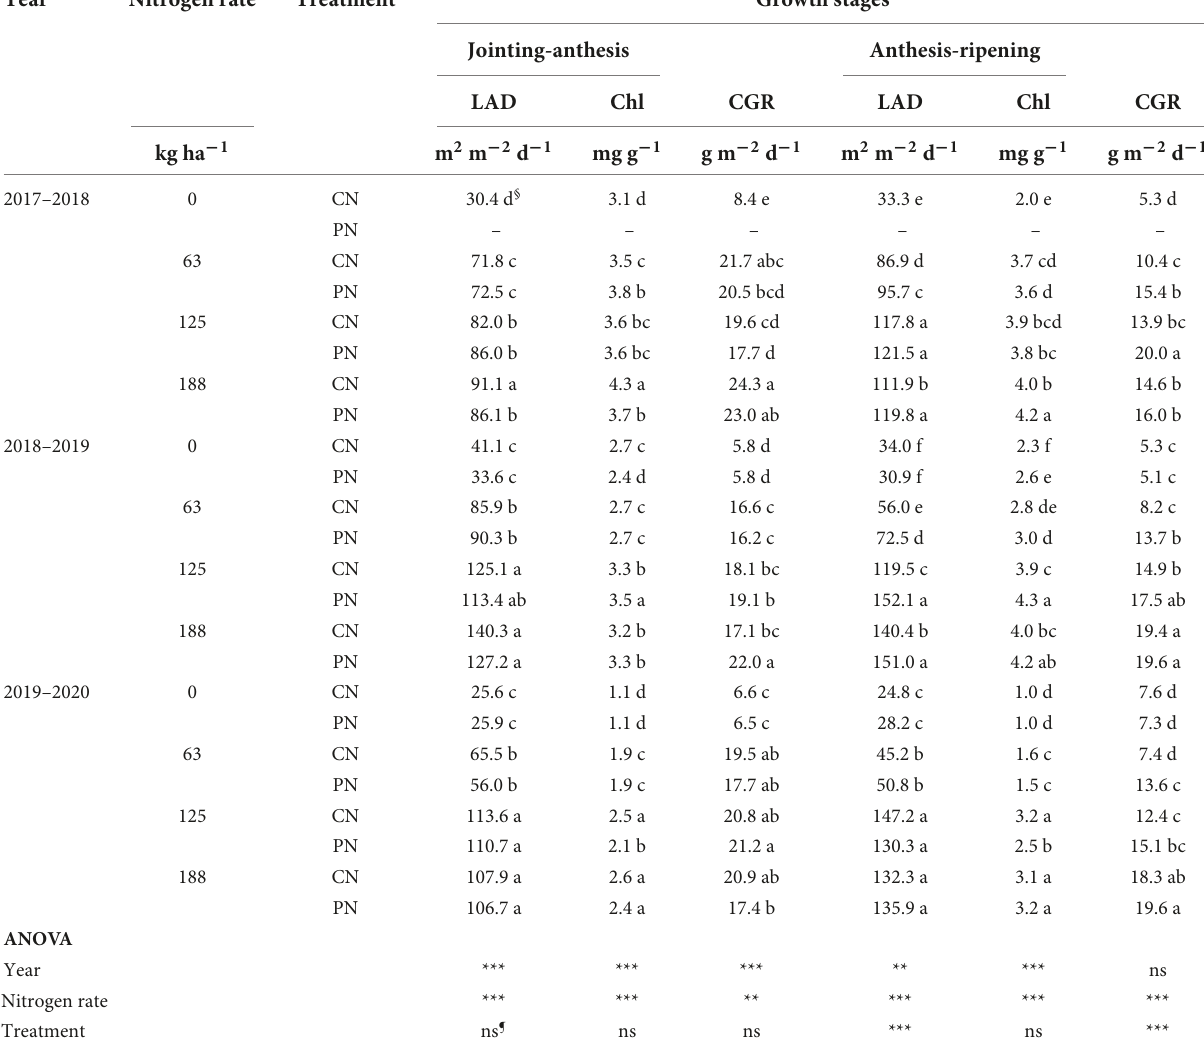
TABLE 4 The main agronomic traits of wheat during the jointing-anthesis and anthesis-ripening growing stages at four N rates under the control (CN) and poly(aspartic acid)-coated urea (PN) treatments from 2017 to 2020. Year Nitrogen